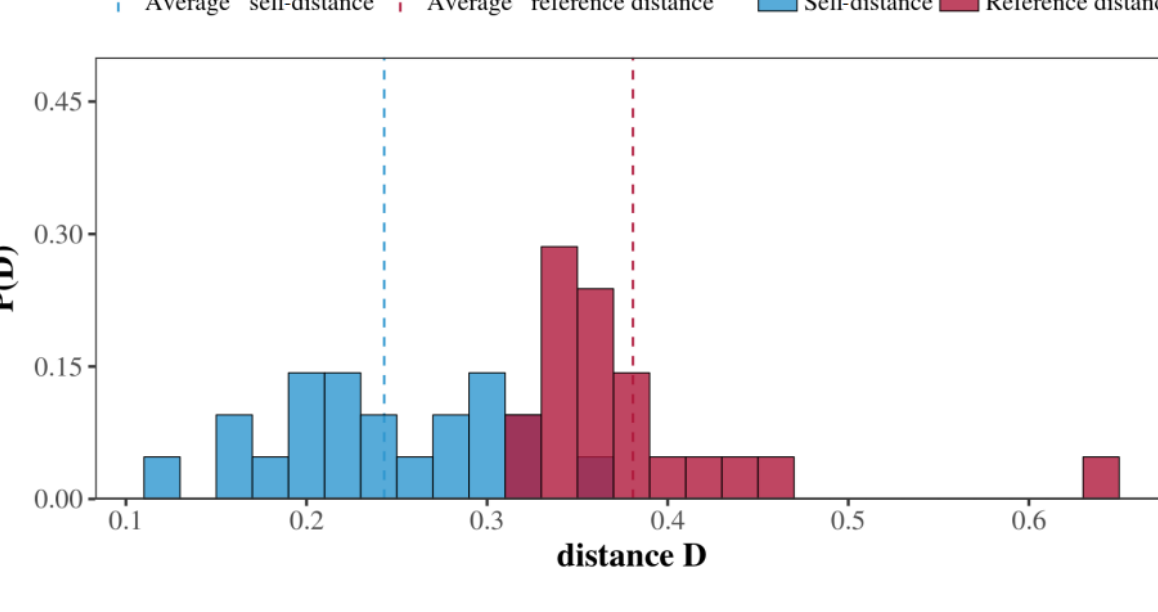
Figure 4. Averaged persistence histogram. Red bars represent average reference distances and blue bars represent average self-distances for all the egos. Blue and red dashed lines represent the average self-distance and reference distance for the entire population, respectively.